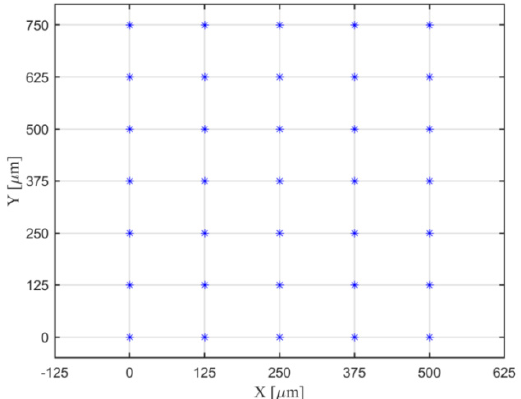
Figure 13. Plots of the calculated centers of the generated data.